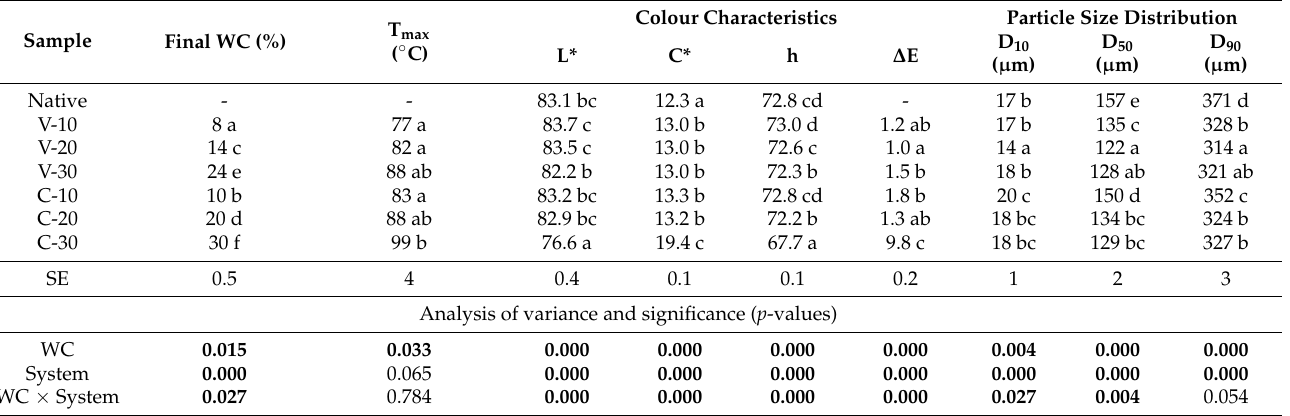
Table 1. Maximum temperature reached and final water content during microwave treatment, colour characteristics and particle size distribution of the flour samples obtained from untreated (native) and microwave-treated quinoa